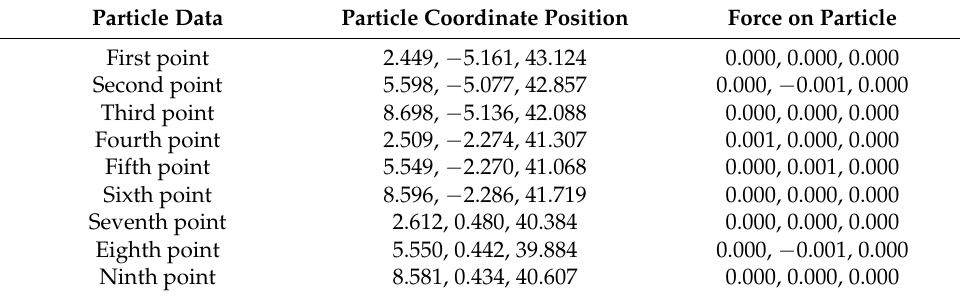
Table 5. Position and stress of particles after the recovery. Particle Data Particle Coordinate